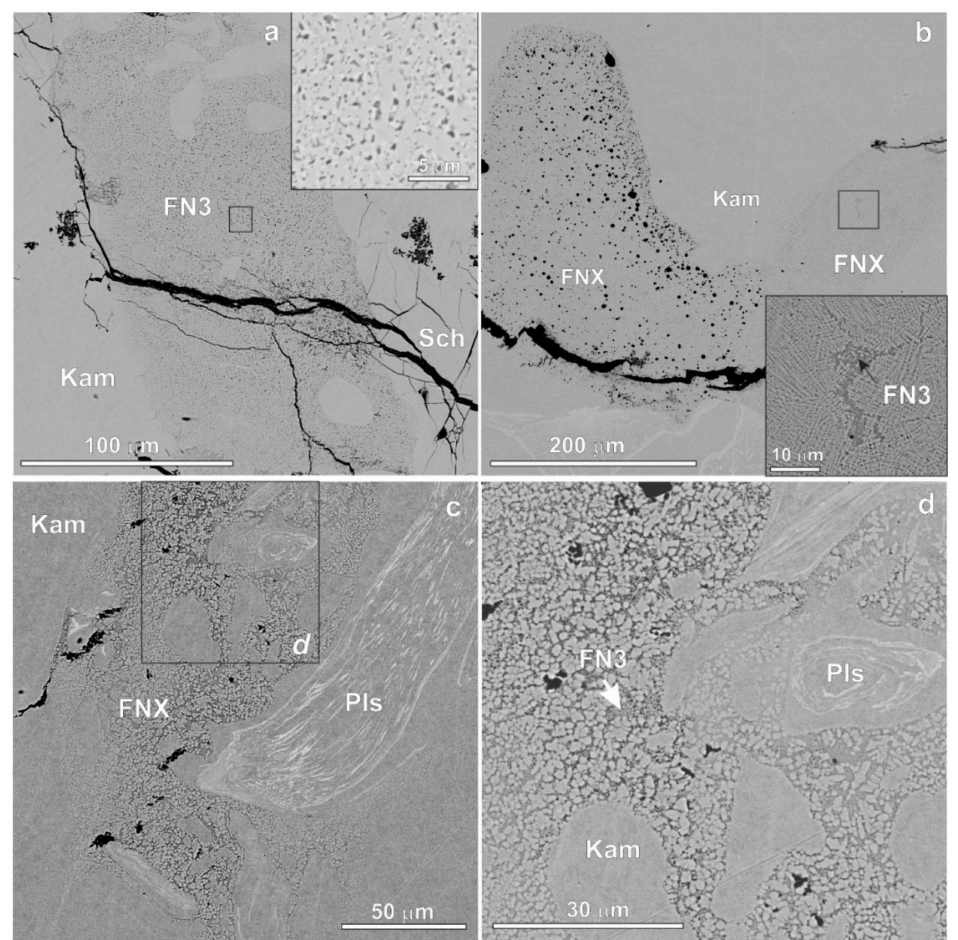
Figure 5. Fe-Ni-P-S aggregates from Elga meteorite. ( a ) Sites 14–15, FN3 represented by quench aggregates of three phases, schreibersite (Sch, grey), troilite (dark), and kamacite (Kam, white); ( b ) Sites 8–9, 23a, interstitial FN2 aggregate in FNX nonstoichiometric matrix; ( c ) Site 28, zone of deformation of plessite with mixed FNX aggregates, some areas shown in ( d ) have compositions corresponding to FN3. Pls—plessite. Black squares show the position of the inserts. See Table S1 for chemical